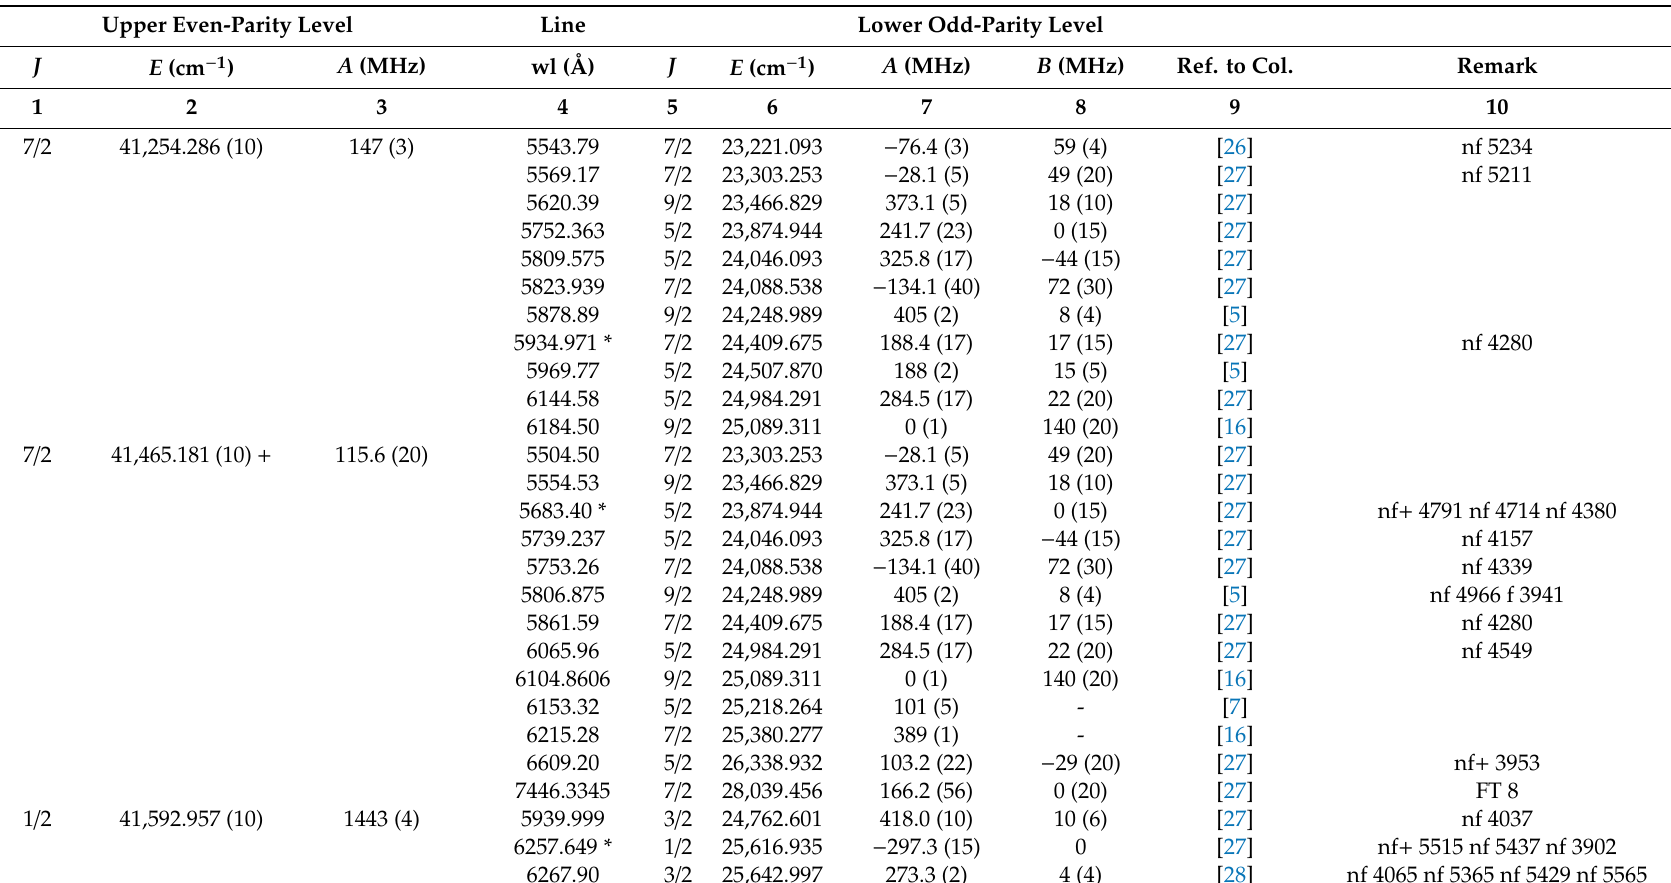
Table 1. New La I energy levels and lines classified by these levels. E —energy; wl—wavelength; tw—this work. OG observation of only the OG signal. FT—wavelength determined from the Fourier transform spectrum with given SNR. nf—LIF line (phase opposite to the OG signal, “negative” LIF); nf + —strong LIF signal. f—LIF line (in phase with the OG signal). Wavelengths in column 10 are given without digits after decimal